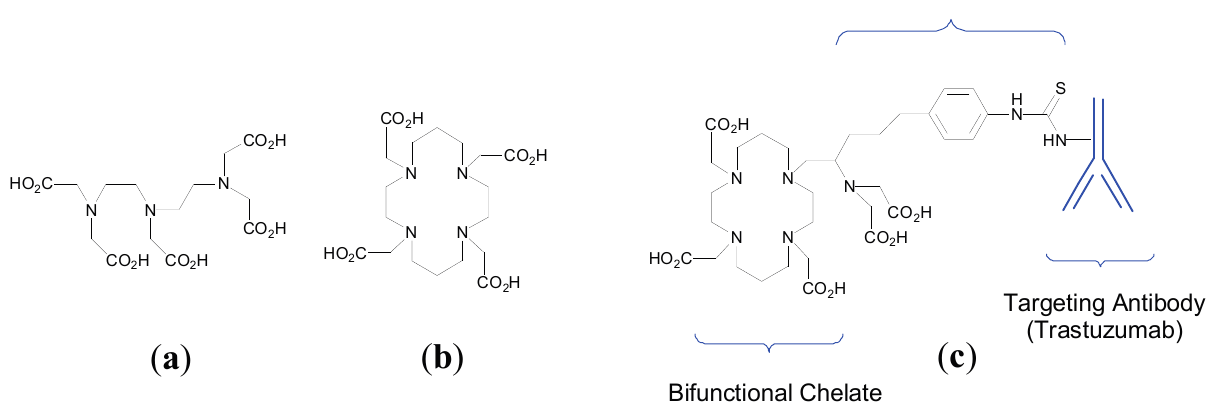
Figure 21. Structures of ( a ) DTPA and ( b ) DOTA, which are representative examples of common chelating agents for 212 Bi and 213 B. ( c ) Representation of 3p-C-DEPA conjugated to